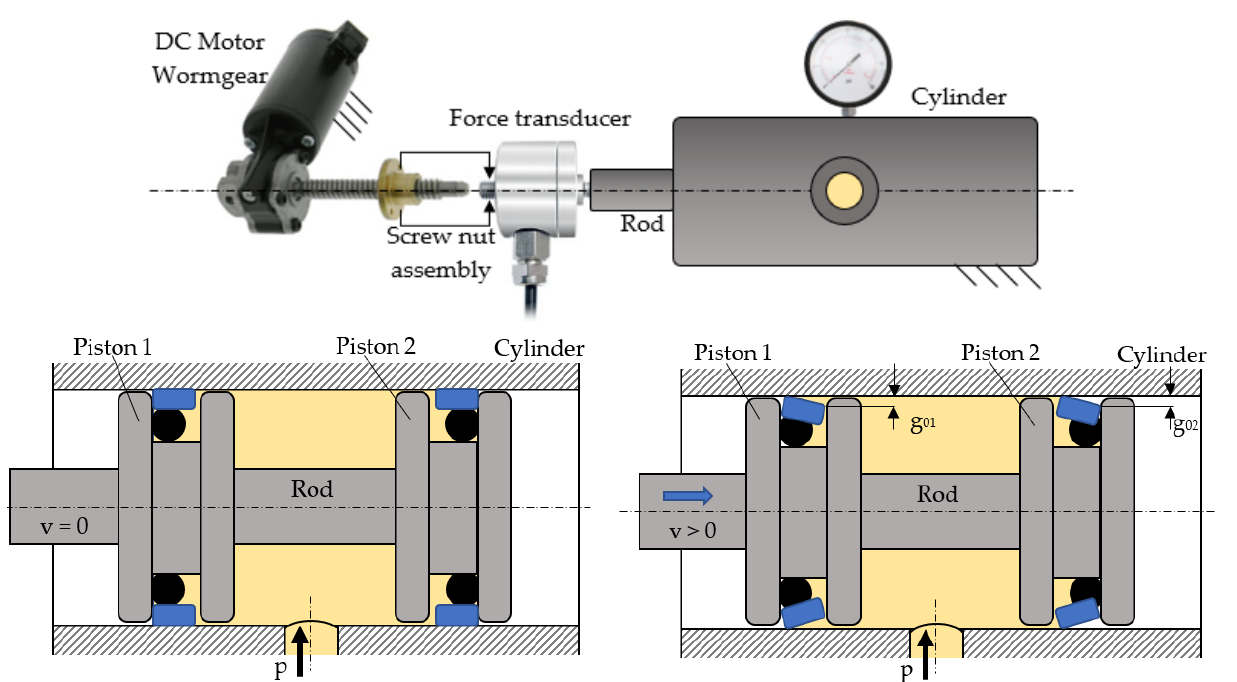
Figure 8. Construction of the test stand for the determination of the kinetic friction coefficient. The utilized force transducer measures the sum of the two kinematic friction forces generated by the tested seals ( F fr k tot_mes ).